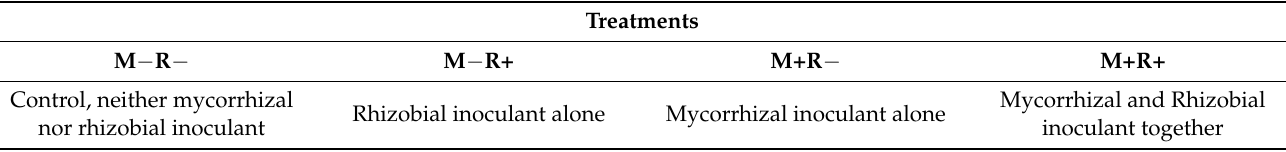
Table A1. Inoculant treatments used in the